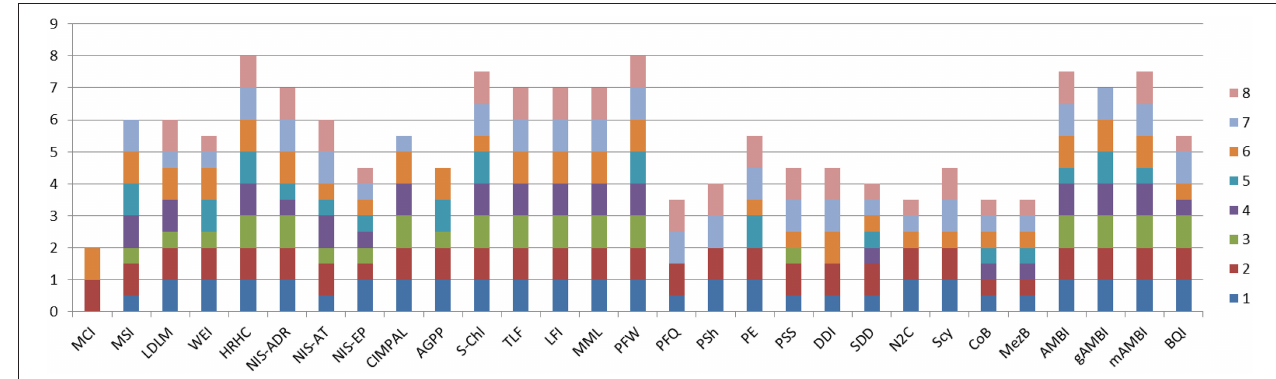
FIGURE 1 | Cumulative quality scoring of the indicators developed and refined during the DEVOTES project. Indicator quality scores are based on the framework to test and evaluate indicator quality (Queiros et al., 2016). Each indicator was evaluated based on eight quality criteria: (1) Scientific basis; (2) Ecosystem relevance; (3) Responsiveness to pressures; (4) Possibility to set targets; (5) Early warning capacity; (6) Concreteness; (7) Cost-Efficiency; (8) Existing and on-going data. For each indicator the quality criteria were evaluated and scored using three evaluation scores: 1, criteria is fully met; 0.5, criteria is partially met; and 0, criteria is not met. The scoring principles for each indicator and criteria are described in detail by Berg et al. (2016). Indicator codes are same as in Table 3